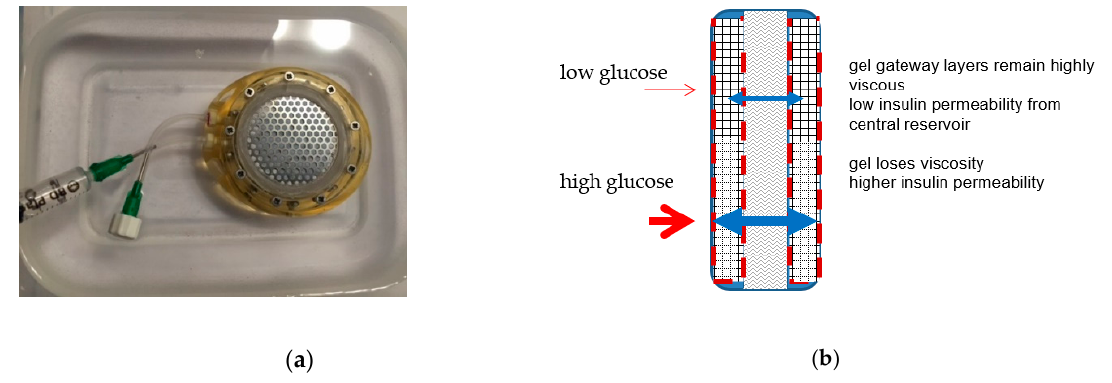
Figure 1. ( a ) Artificial pancreas (InSmart). ( b ) Mechanism for insulin delivery from artificial pancreas (InSmart) .